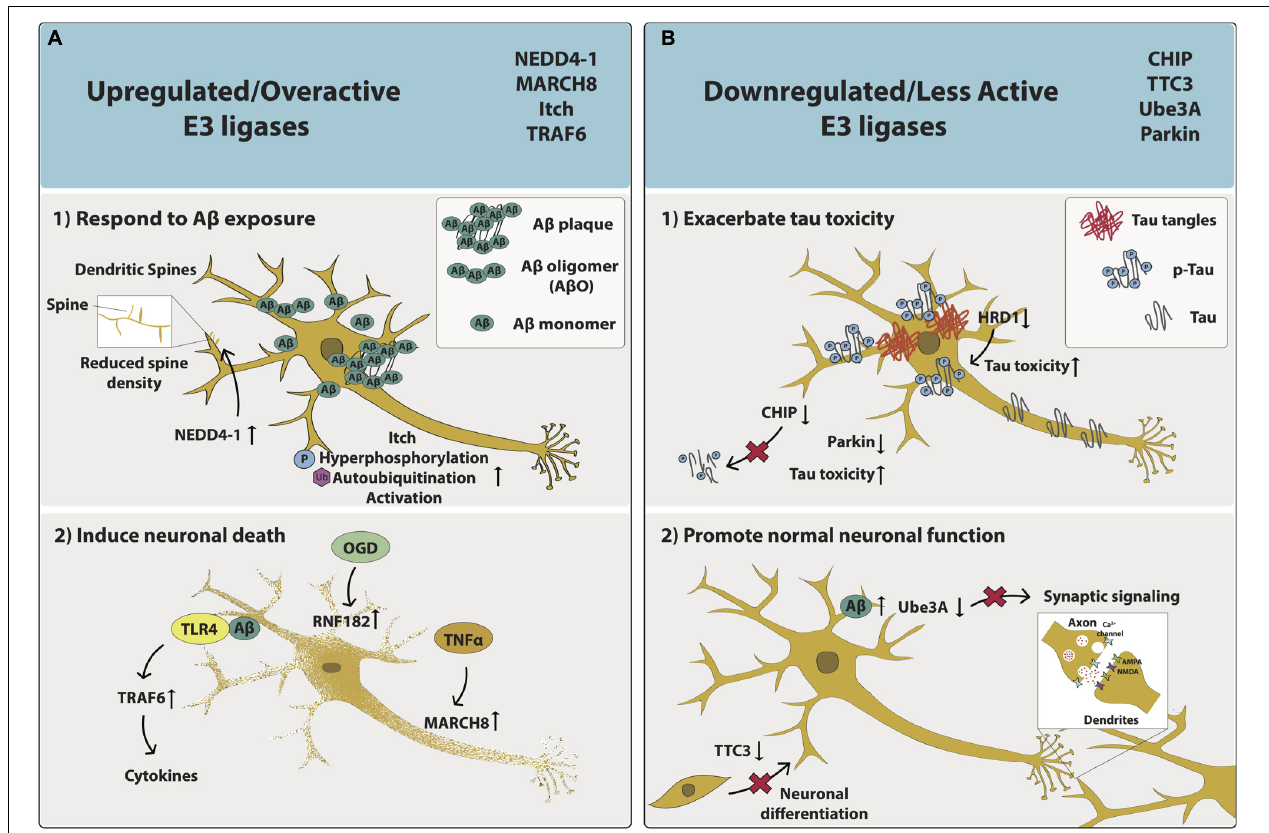
FIGURE 2 | The phenotypic effects of aberrant E3 ligase function on AD neurons. The impacts of upregulated/overactive E3 ligases NEDD4-1, MARCH8, Itch and TRAF6 as well as downregulated/less active E3 ligases CHIP, TTC3, Ube3A, and Parkin on neuronal function and/or health are captured specifically within the context of AD. (A) Upregulated/overactive E3 ligases – (1) respond to A β exposure: NEDD4-1 relocates to dendritic spines and is overexpressed, leading to decreased spine density. Itch is hyperphosphorylated, autoubiquitinated, and becomes activated; or (2) induce neuronal death: A β interacts with TLR4, activates TRAF6, and results in cytokine release. OGD increases RNF182 expression. TNF α increases MARCH8 expression. (B) Downregulated/less active E3 ligases ˝U (1) exacerbate tau toxicity: Tau expression leads to reduced CHIP expression and less CHIP-induced tau elimination. HRD1 expression is decreased and p-Tau expression is increased. Parkin expression is decreased; or (2) promote normal neuronal function: TTC3 expression is decreased and neuronal differentiation is disrupted. A β levels are increased and Ube3A levels are decreased, leading to synaptic